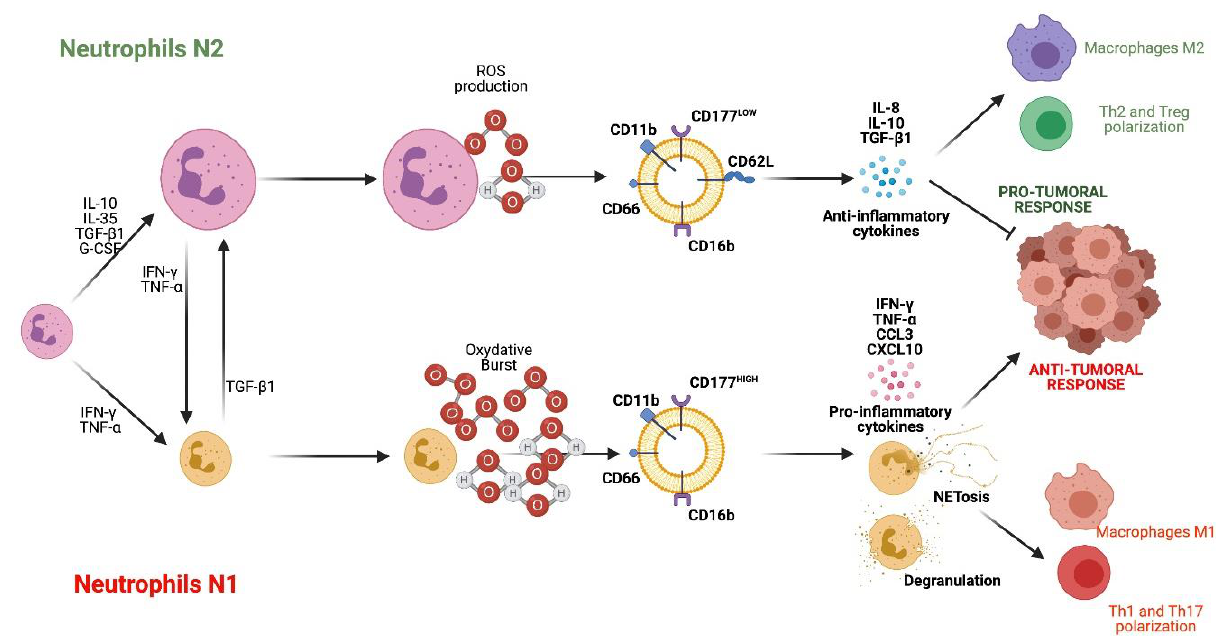
Figure 2. Neutrophil subsets N1 and N2. N2 neutrophils are differentiated in the presence of IL-10, IL-35, TGF- β 1, and G-CSF. N2 cells are characterized by producing ROS, IL-10 and TGF- β 1, expressing CD11b, CD16b, CD62L, CD66 and CD177LOW, and having a pro-tumor and anti-inflammatory function. On the other hand, N1 neutrophils differentiate in the presence of IFN- γ and TNF- α . They are characterized by producing oxidative burst, IFN- γ , TNF- α , CCL3, CXCL4 and expressing CD16b, CD11b, CD66 and CD177HIGH, and fulfill an anti-tumor and pro-inflammatory role. References: [16,18,23,24,72,76]. (Created with http://biorender.com).